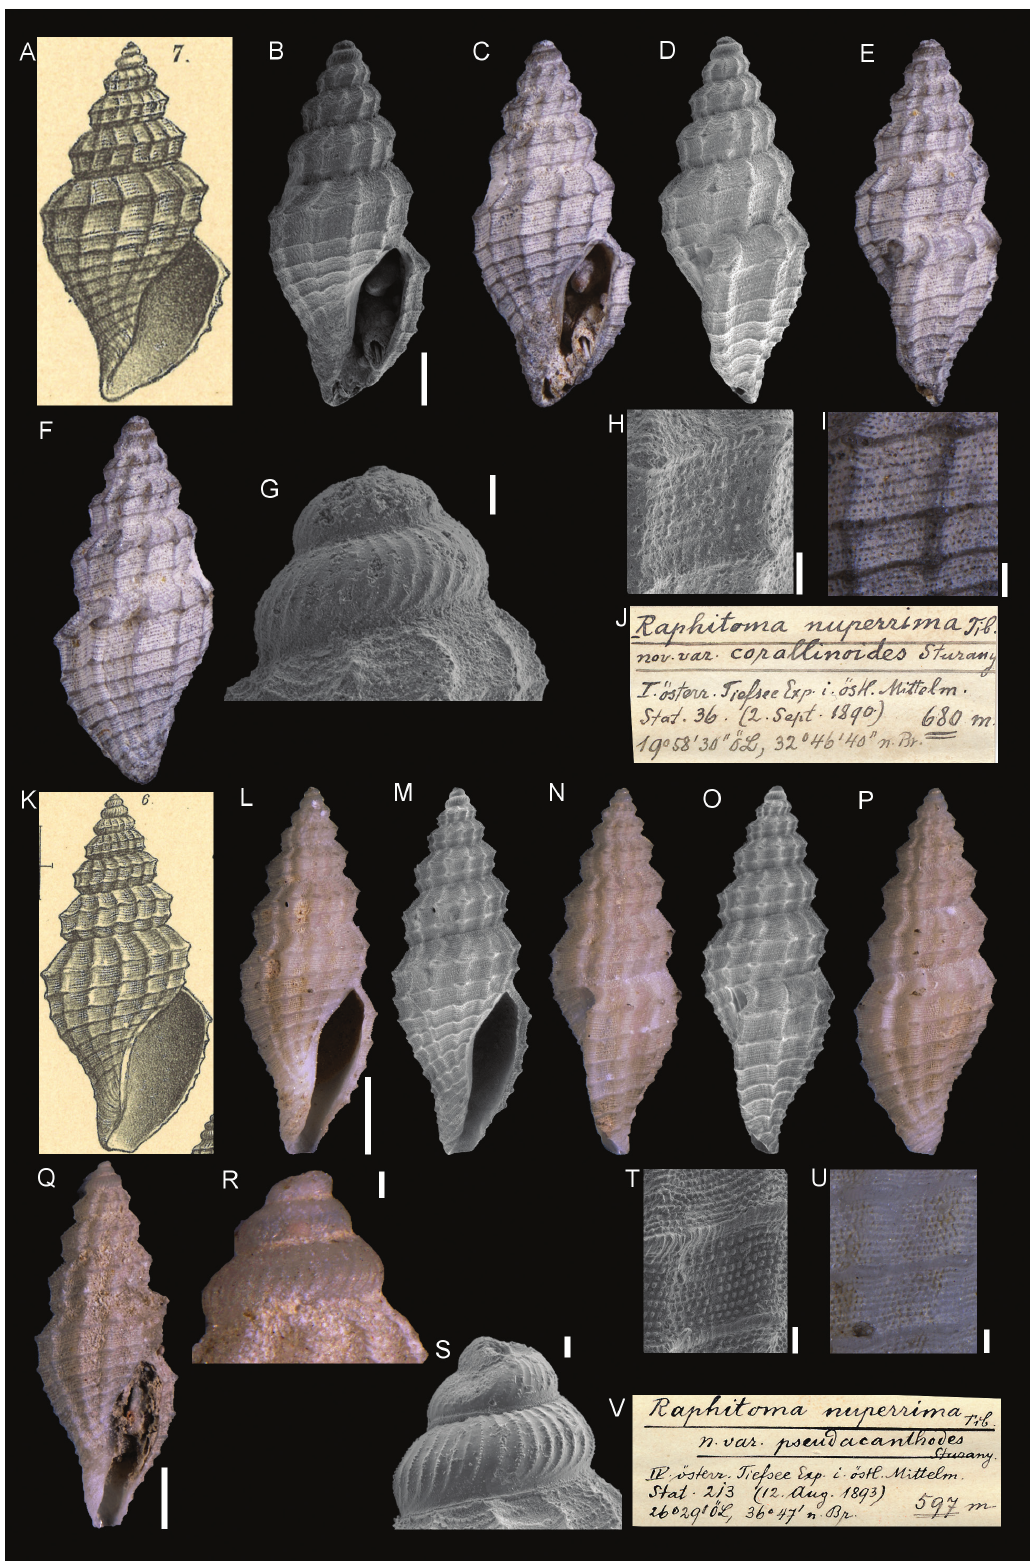
Figure 8. A–J . Raphitoma nuperrima var. corallinoides Sturany, 1896, holotype NHMW 13013, Station 36, north of Benghazi, Lib- ya, 680 m: original figure in Sturany, 1896 ( A ), front ( B–C ), side ( D–E ) and back ( F ) views, apex ( G ), microsculpture ( H–I ), orig- inal label ( J ). K–P , T–V . Raphitoma nuperrima var. pseudacanthodes Sturany, 1896, syntype NHMW 13014a, Station 213, north of Astypalaia, Sporades, Greece, 597 m: original figure in Sturany, 1896 ( K ), front ( L–M ), side ( N–O ) and back ( P ) views, micro- sculpture ( T–U ), original label ( V ). Q–R . Raphitoma nuperrima var. pseudacanthodes Sturany, 1896, syntype NHMW 13014b (same locality as 13014a): front ( Q ), apex ( R–S ). Scale bars: 1 mm ( B–F , L–Q ); 0.1 mm ( G , R–U ); 0.2 mm ( H–I